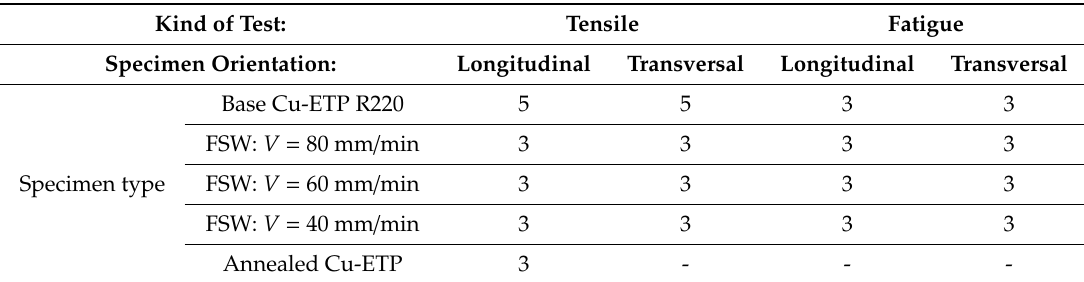
Table 1. Tensile and fatigue test matrix.